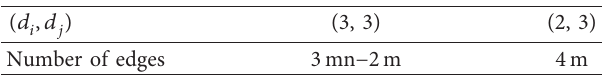
Table 2: Edge partition of TUZC vertices of each edge.